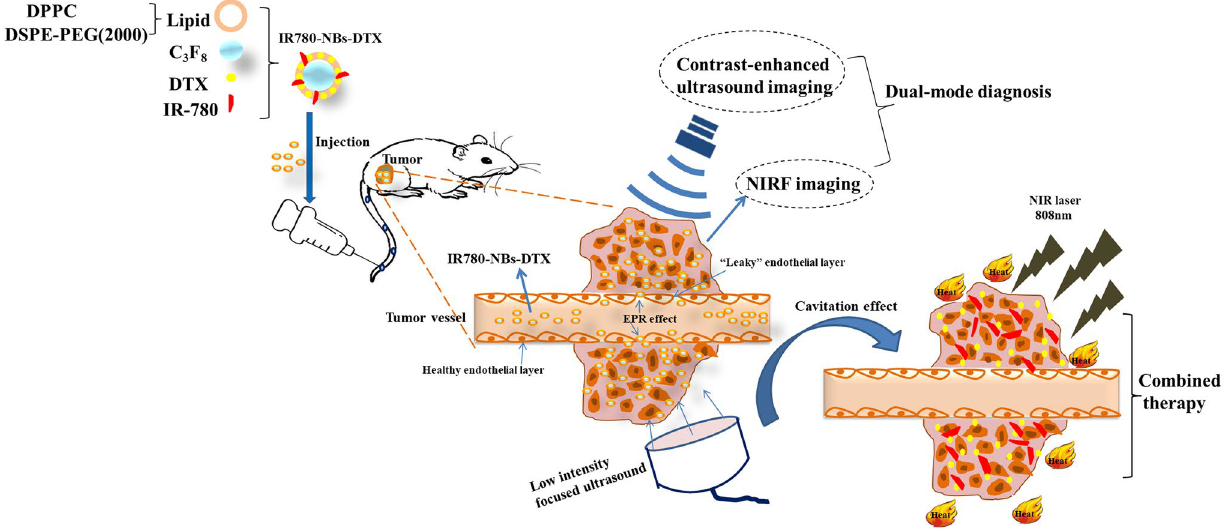
Figure 1. Schematic illustration of IR780-NBs-DTX preparation, molecular targeted imaging and combined treatment of tumors.